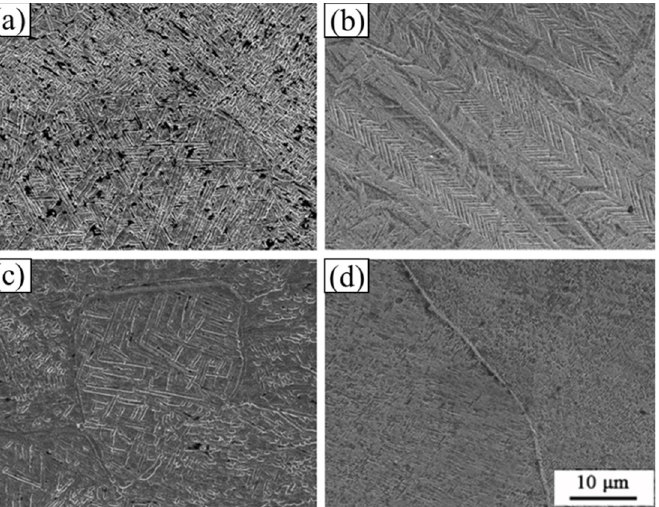
Figure 6. Ti-1023 microstructure of torsional region at different temperatures: ( a ) 300 °C; ( b ) 500 °C; ( c ) 700 °C; ( d ) 900 °C.